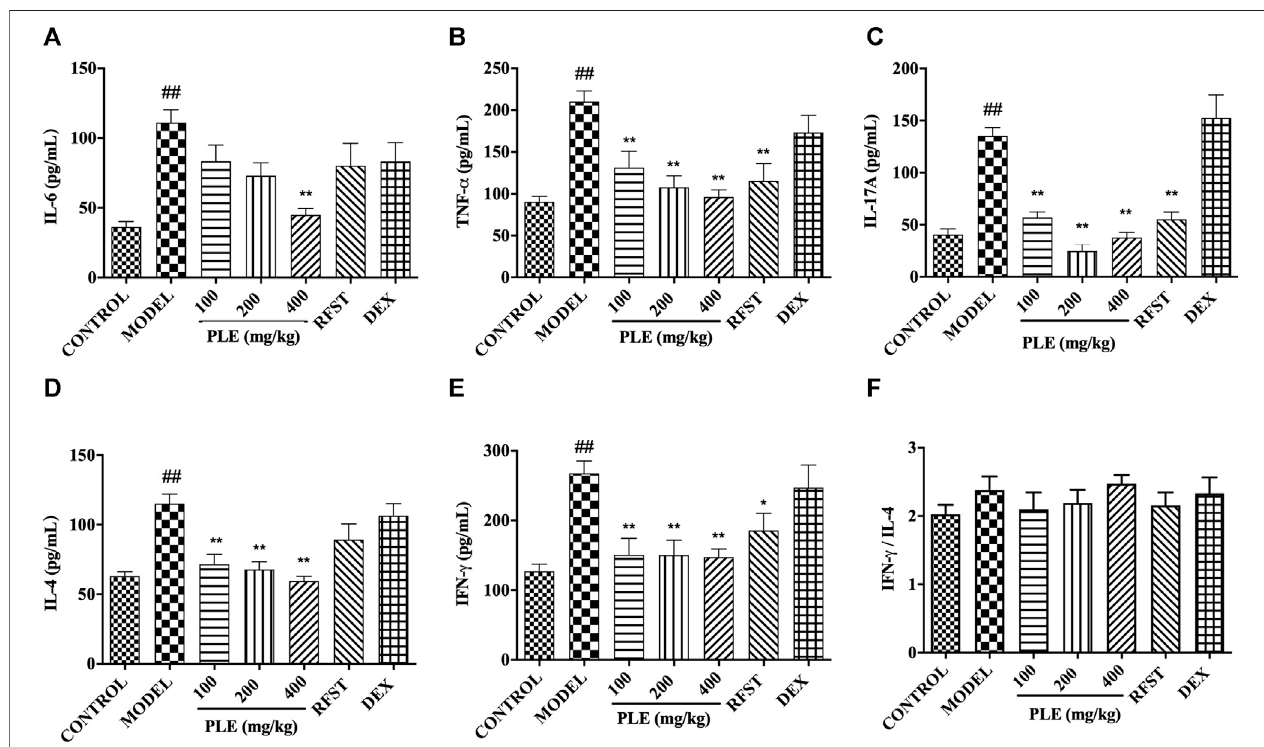
FIGURE 2 | Effects of the PLE on the levels of in fl ammatory cytokines IL-6, (A) TNF- α , (B) IL-17A, (C) IL-4, and (D) IFN- γ (E) , and the ratio of IFN- γ /IL-4 (F) in the BALF. Data were shown as mean ± SEM, n (cid:2) 8; ## p < 0.01 compared with the CONTROL group; * p < 0.05 and ** p < 0.01 compared with the MODEL group.